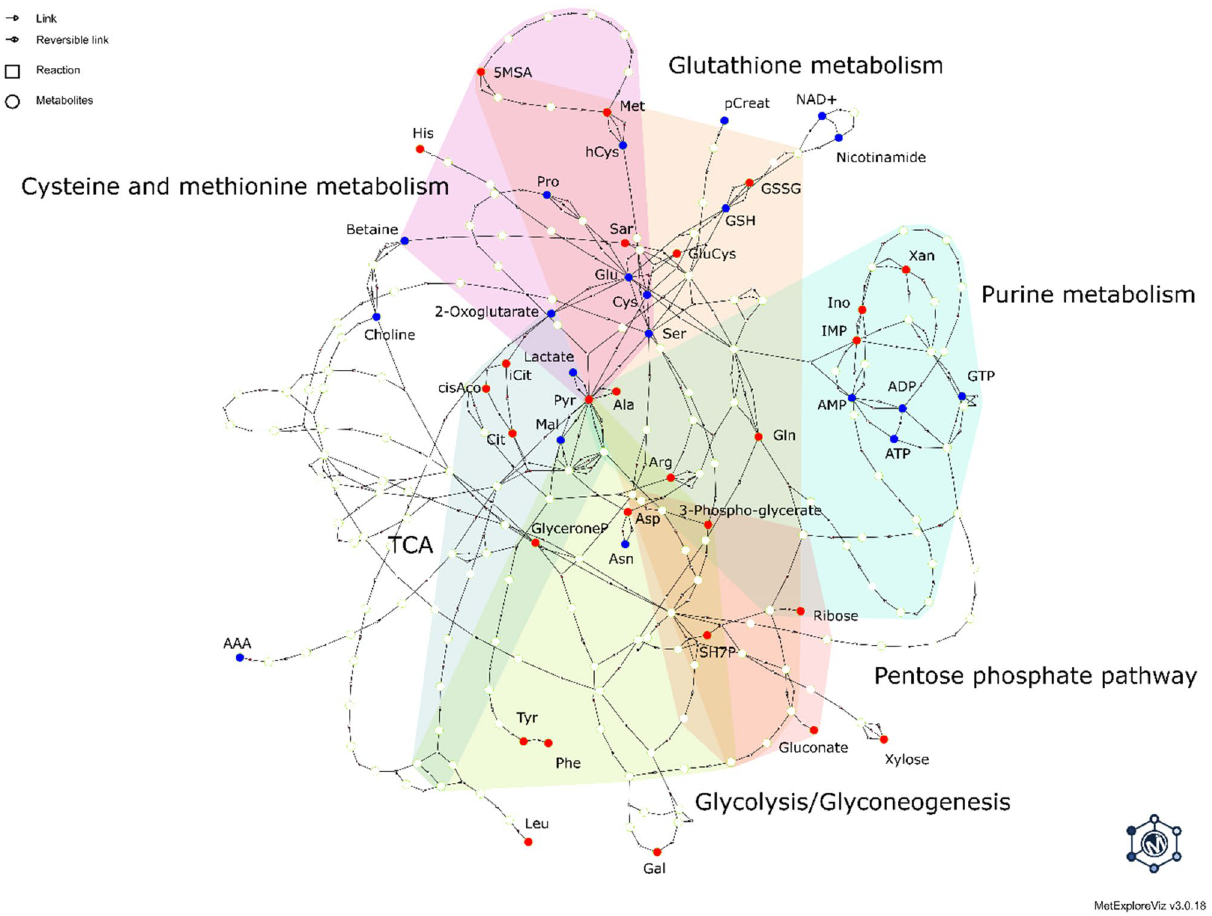
Figure 4. Sub-network constructed from the metabolic network of all possible KEGG reactions, corresponding to the union of all lightest paths between each pair of metabolites in the metabolic fingerprint of redox stress triggered by H 2 O 2 . Metabolites depicted as red nodes correspond to increasing amounts, while as blue nodes to decreasing amounts. Six major distinct pathways where the modulations by redox stress are found are highlighted by different colors. AAA: alpha-Aminoadipic acid, ADP: Adenosine diphosphate, Ala: Alanine, AMP: Adenosine monophosphate, Arg: Arginine, Asp: Aspartate, ATP: Adenosine triphosphate, Cit: Citrate, cisAco: cis-Aconitate, GluCys: gamma-Glutamyl-cysteine, Gln: Glutamine, Glu: Glutamate, GSH: Glutathione (reduced), GSSG: Glutathione (oxidized), His: Histidine, iCit: Isocitrate, IMP: Inosine monophosphate, Leu: Leucine, Mal: Malate, Met: Methionine, 5MSA: 5-Deoxy-5-Methylthioadenosine, NAD+: Nicotinamide adenine dinucleotide, Phe: Phenylalanine, pCreat: Phosphocreatine, Tyr: Tyrosine, SH7P: Sedoheptulose-7-phosphate, Sar: Sarcosine, Ser: Serine, Xan: